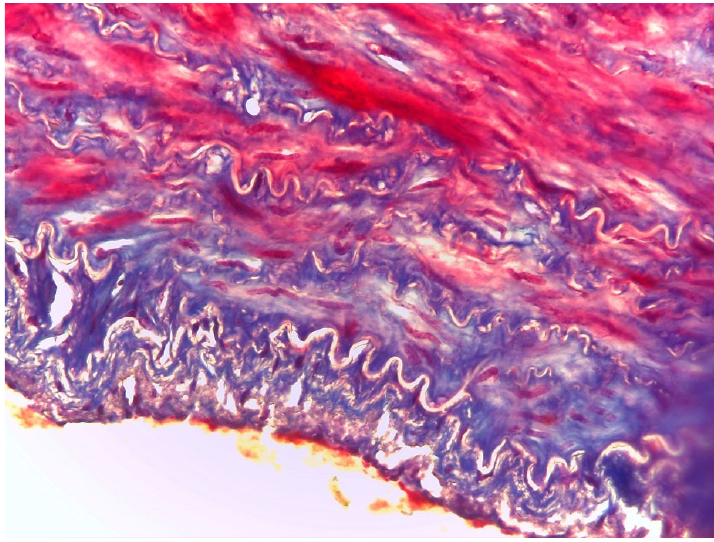
Figure 3. Bovine carotid artery with false aneurysm. Mallory ʹ s trichrome (40×).